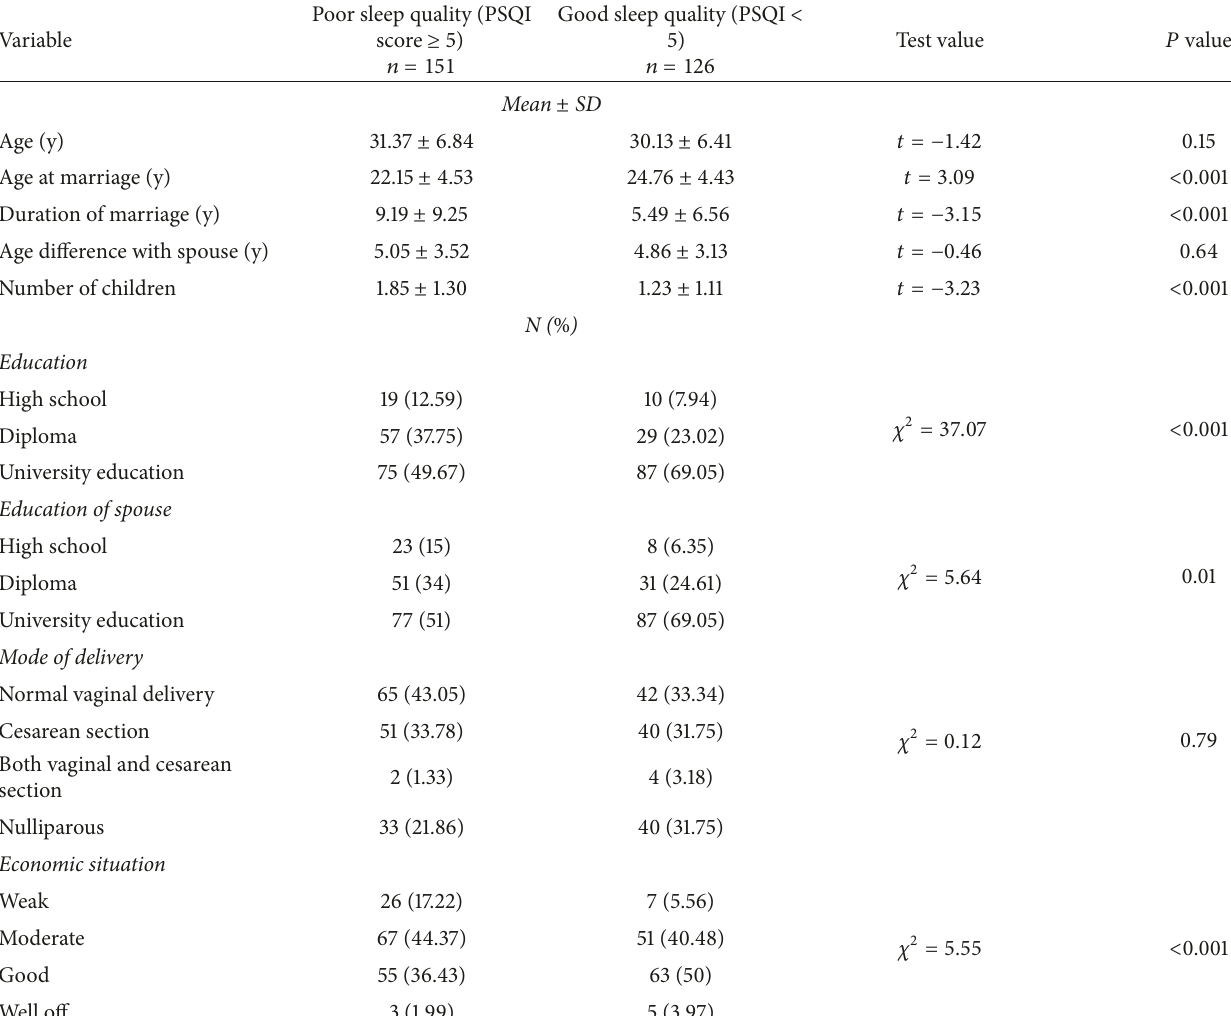
Table 1: Sociodemographic characteristics of women with poor sleep quality and good sleep quality.